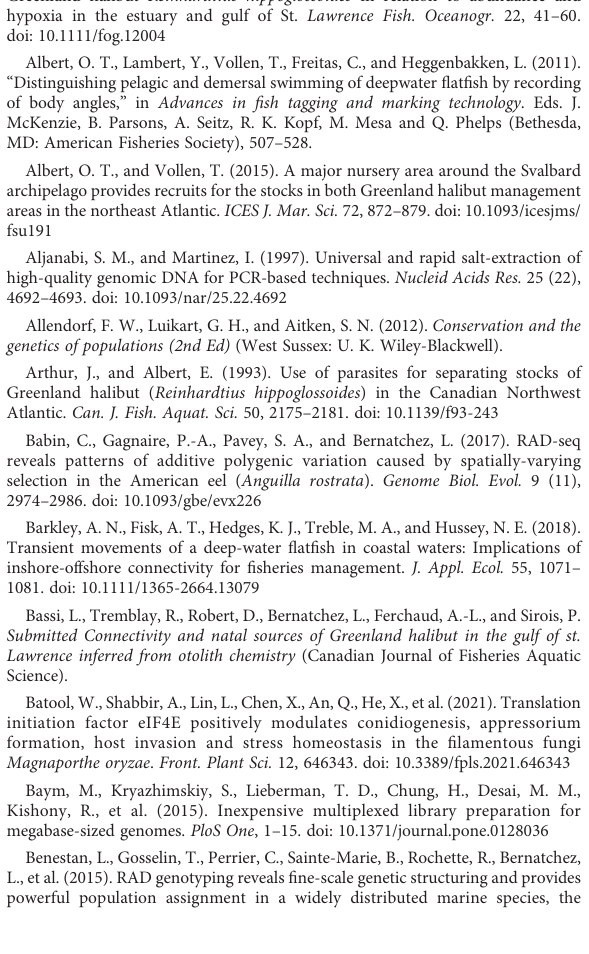
SUPPLEMENTARY TABLE 1 Mean pairwise Fst estimates among each locality containing more than 30 individuals.